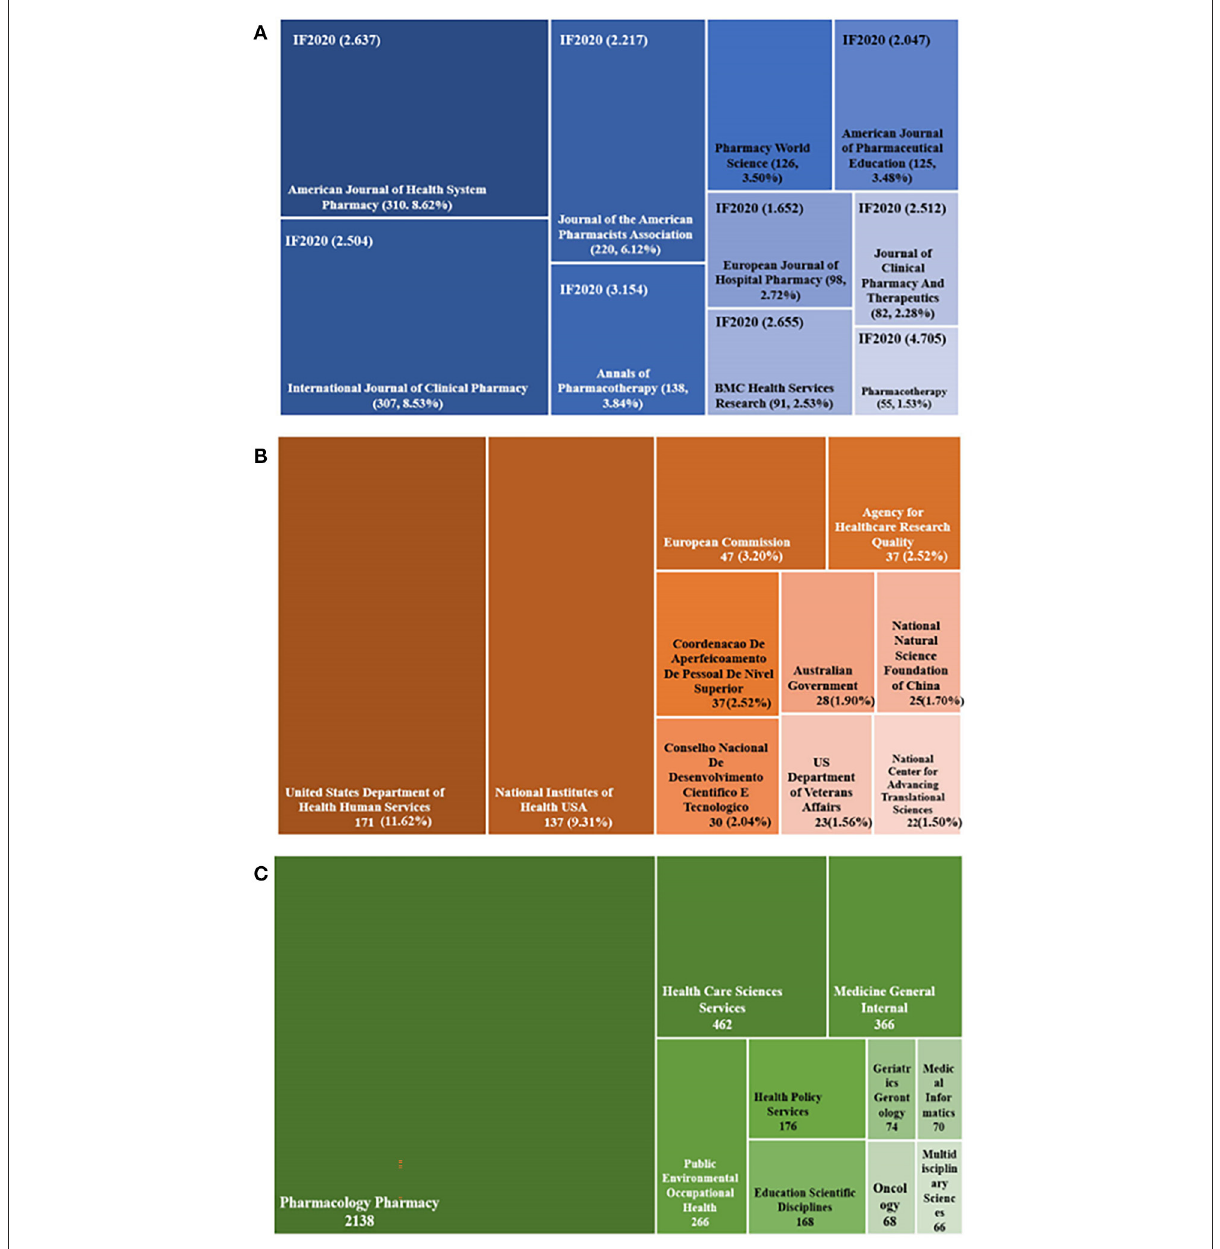
FIGURE6 Distribution of journals, funding agencies, and subject categories. (A) The tree-map of top 10 journals. (B) The tree-map of funding agencies. (C) The tree-map of subject